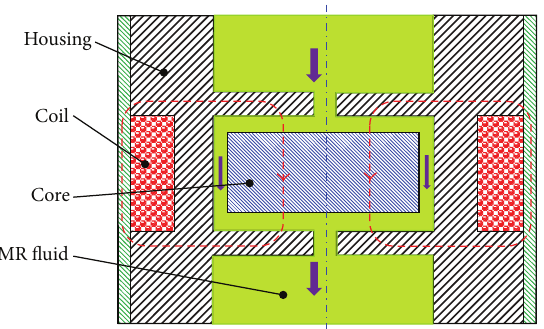
Figure 16: MR valve with external coil